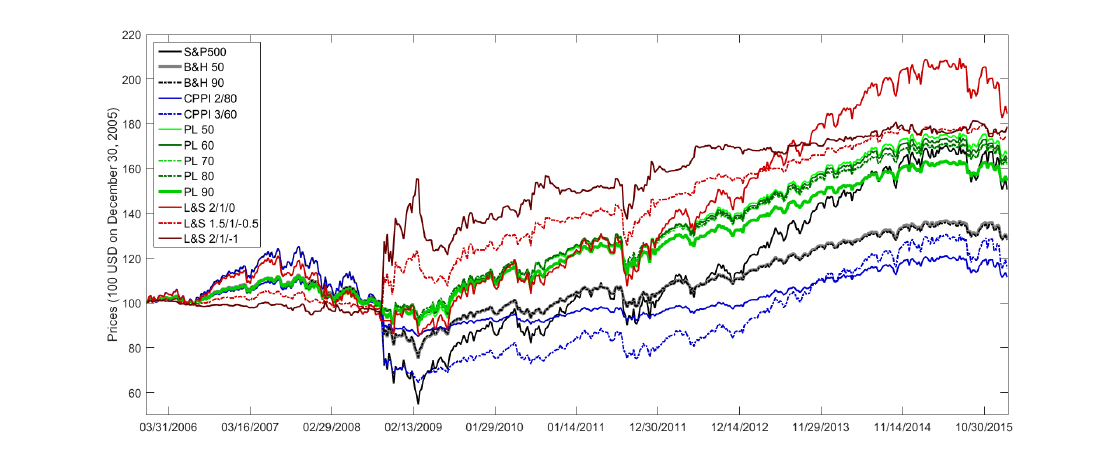
Figure A4. Evolution of an initial investment of 100 USD in diverse single-market strategies (S&P500, B&H, CPPI, PL and L&S) over the out-of-sample period from December 30, 2005 until February 5, 2016. All strategies are weekly rebalanced and have zero transaction costs.